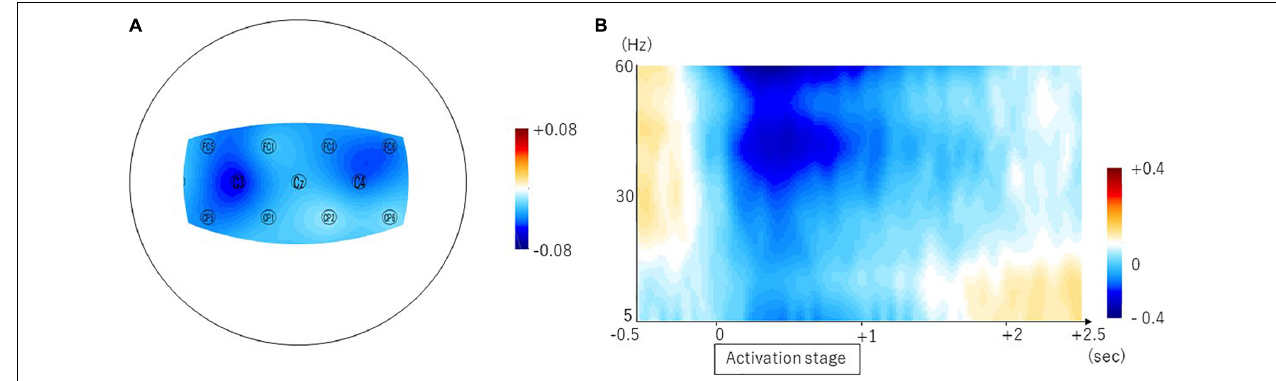
FIGURE 2 | Brain areas showing swallow-related ERDs in the beta frequency band and the temporal property. The topomap display of the swallow-related ERDs is shown in panel (A) . The ERDs are prominent in the bilateral sensorimotor cortices. The temporal property is shown in panel (B)